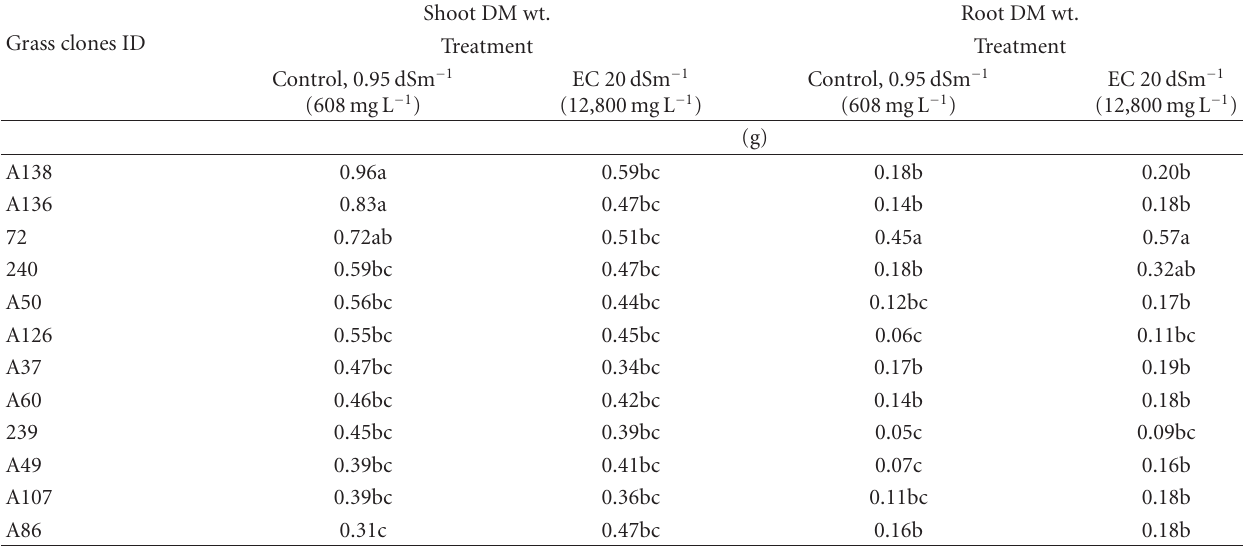
Table 3: Shoot and root dry matter (DM) weights of various saltgrass clones under the control and salt (NaCl) stress conditions. Grass clones ID